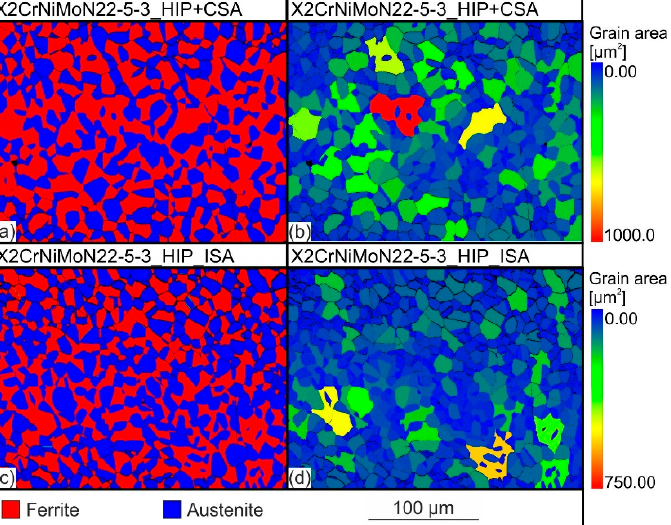
Figure 4. EBSD phase images ( a , c ) and grain size mappings ( b,d ) of the X2CrNiMoN22-5- 3_HIP+CSA and X2CrNiMoN22-5-3_HIP_ISA